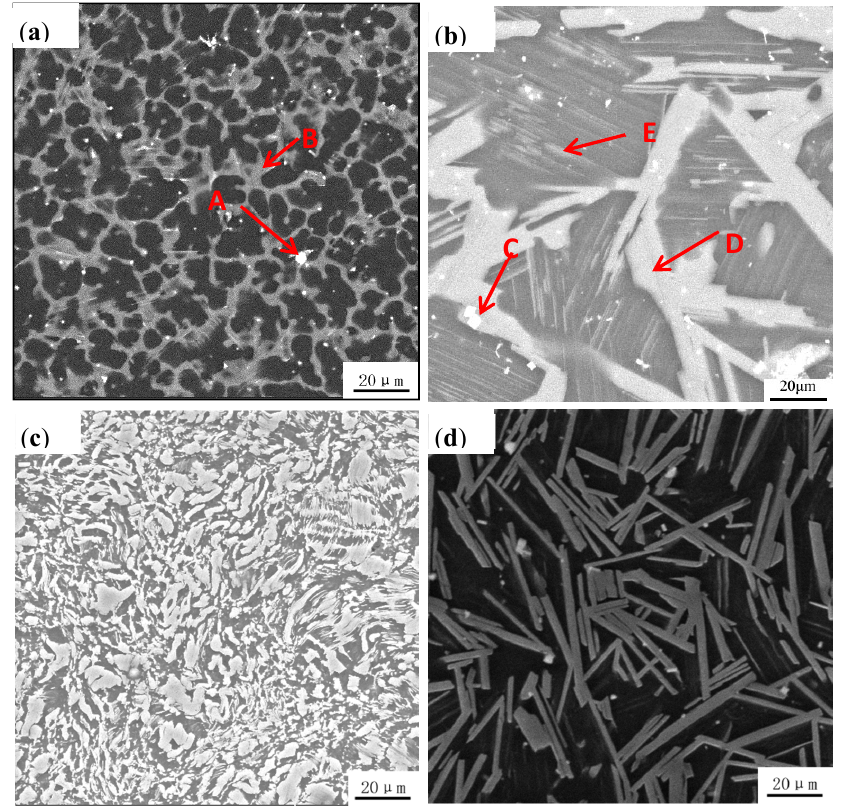
Figure 2. Scanning electron microscope (SEM) images of Mg 95.33 Zn 2 Y 2.67 alloy with different morphologies of long-period stacking ordered (LPSO) phases: ( a ) as-cast, ( b ) pre-extrusion heat-treated, ( c ) as-extruded, ( d ) post-extrusion heat-treated.